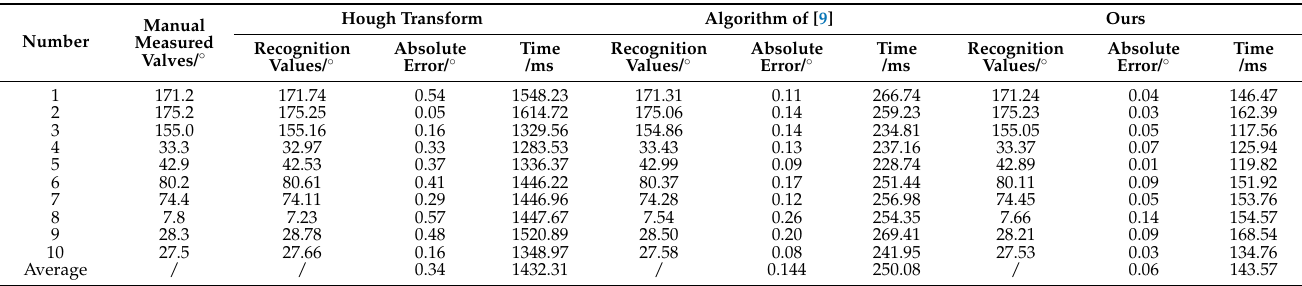
Table 4. Position recognition of ten dial gauges by four methods.